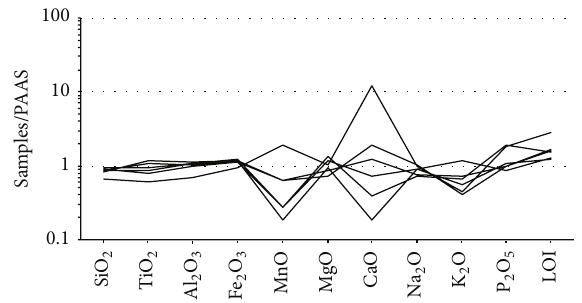
Figure 3: PAAS-normalized major elements